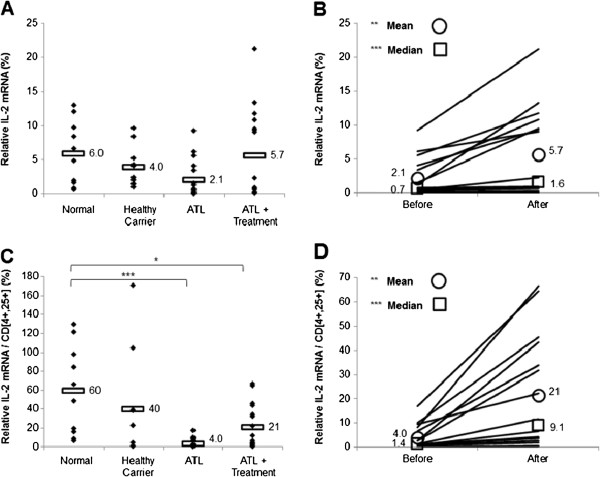
Treatment with arsenic/IFN/zidovudine increased IL-2 expression. A. IL-2 transcript levels in normal blood donors (n=10), healthy carriers of HTLV-I (n=10) and ATL patients (n=16) at initiation and 30 days after treatment with arsenic/IFN/zidovudine. Rectangles represent mean values. B. Mean and median IL-2 transcript levels of individual ATL patients at initiation and 30 days after treatment with arsenic/IFN/zidovudine. C, D. Relative expression of IL-2 transcripts after normalization to the number of CD4+CD25+ ATL cells. All values are expressed as percentage of human beta2-microglobulin used as internal control. *, **, *** indicate p values less than 0.05, 0.01 and 0.001 respectively.